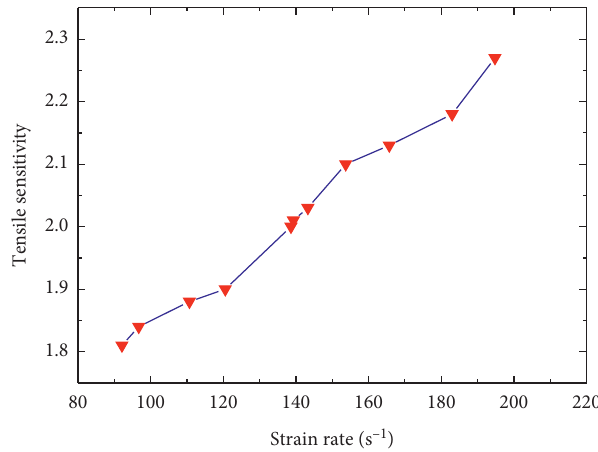
Figure 8: Tensile sensitivity-strain rate.